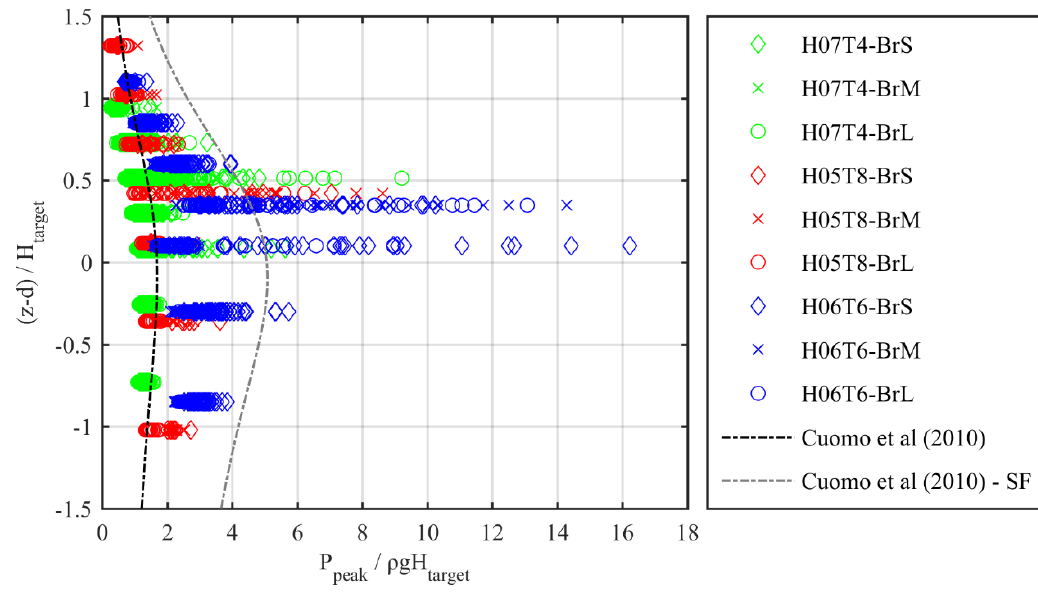
Figure 5. Example pressure time histories at three different locations on the seawall (see also Figure 3) for test case H06T6. Pressure is normalized with hydrostatic pressure of the target wave height (0.6 m), and time with wave period (6 s).